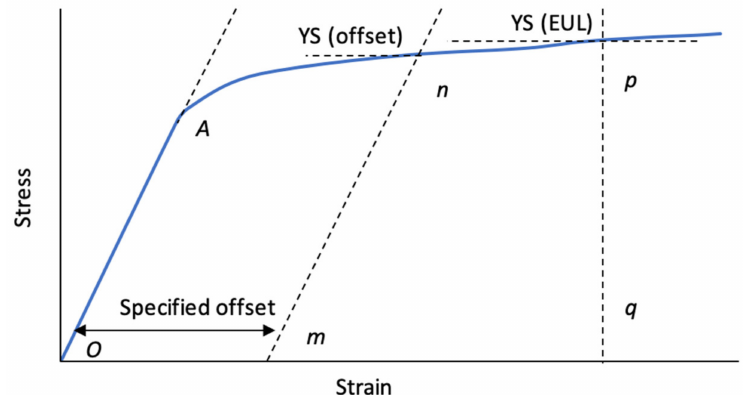
Figure 3. Stress–strain diagram illustrating the determination of both the Proof Strength, Non- Proportional Extension (also known as Offset Yield) and the Proof Strength, Total Extension (also known as Extension Under Load, EUL) [10].